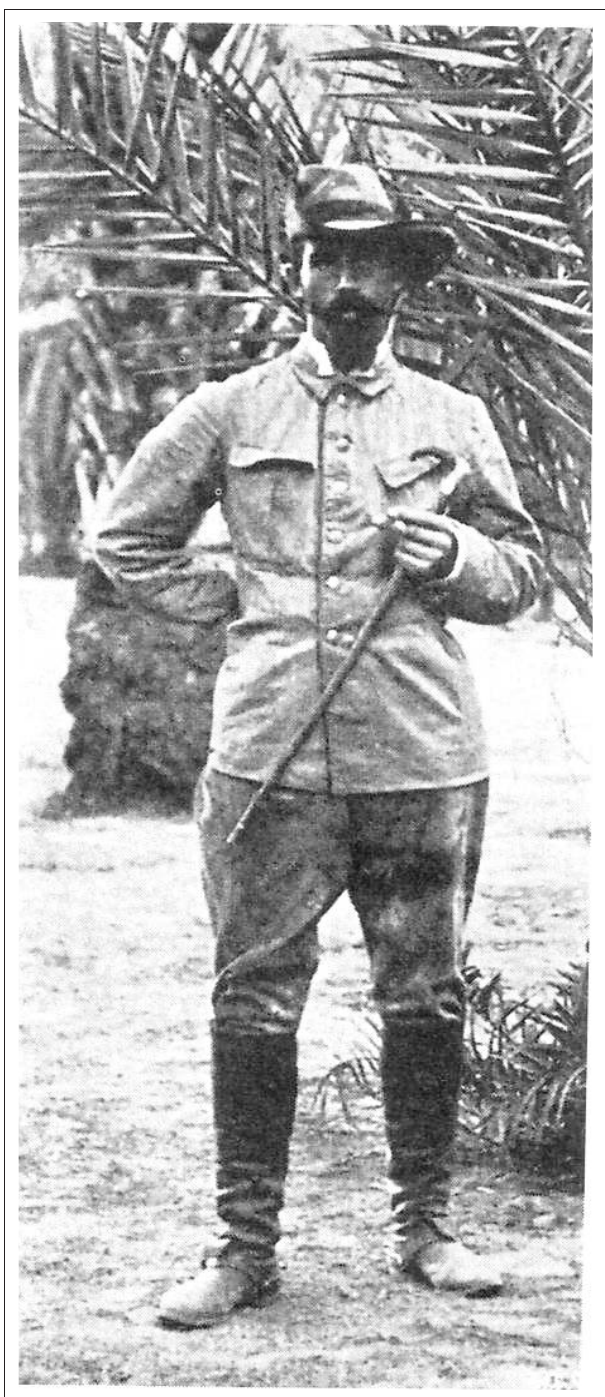
FIGURE 5: Dr Wilhelm Rickmann, the first veterinarian in German South-West